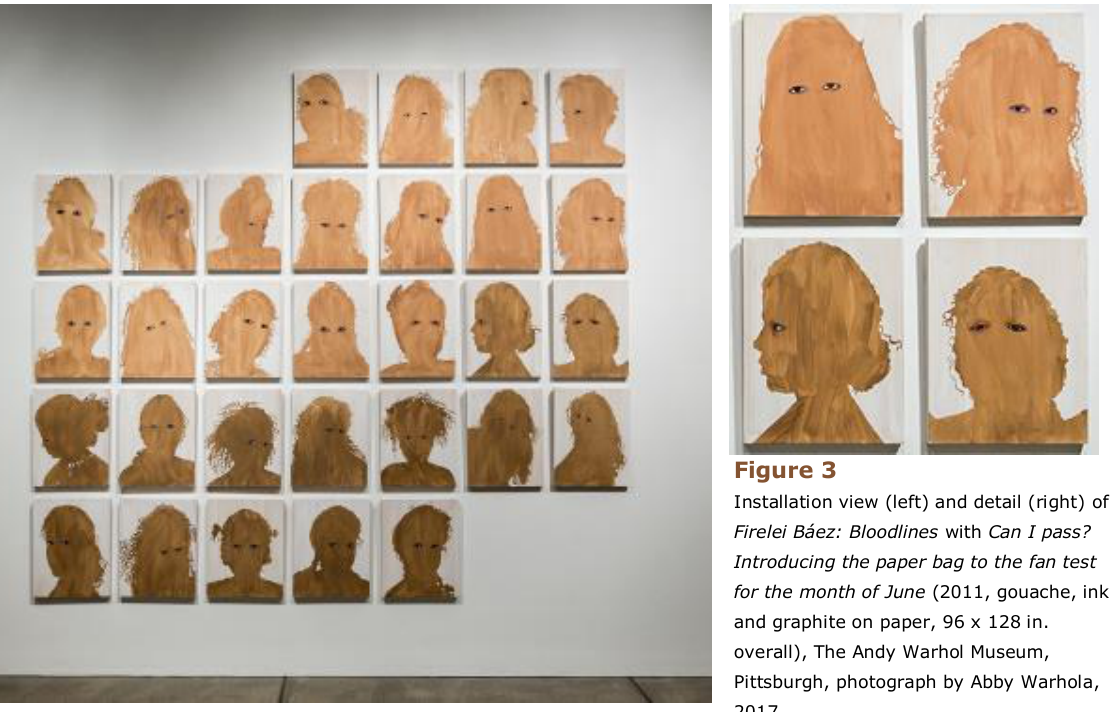
Installation view (left) and detail (right) of Firelei Báez: Bloodlines with Can I pass? Introducing the paper bag to the fan